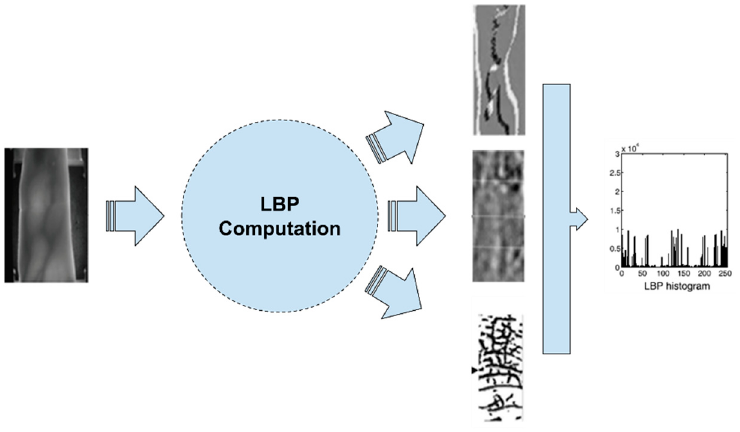
Figure 5. Feature extraction using LBP-based